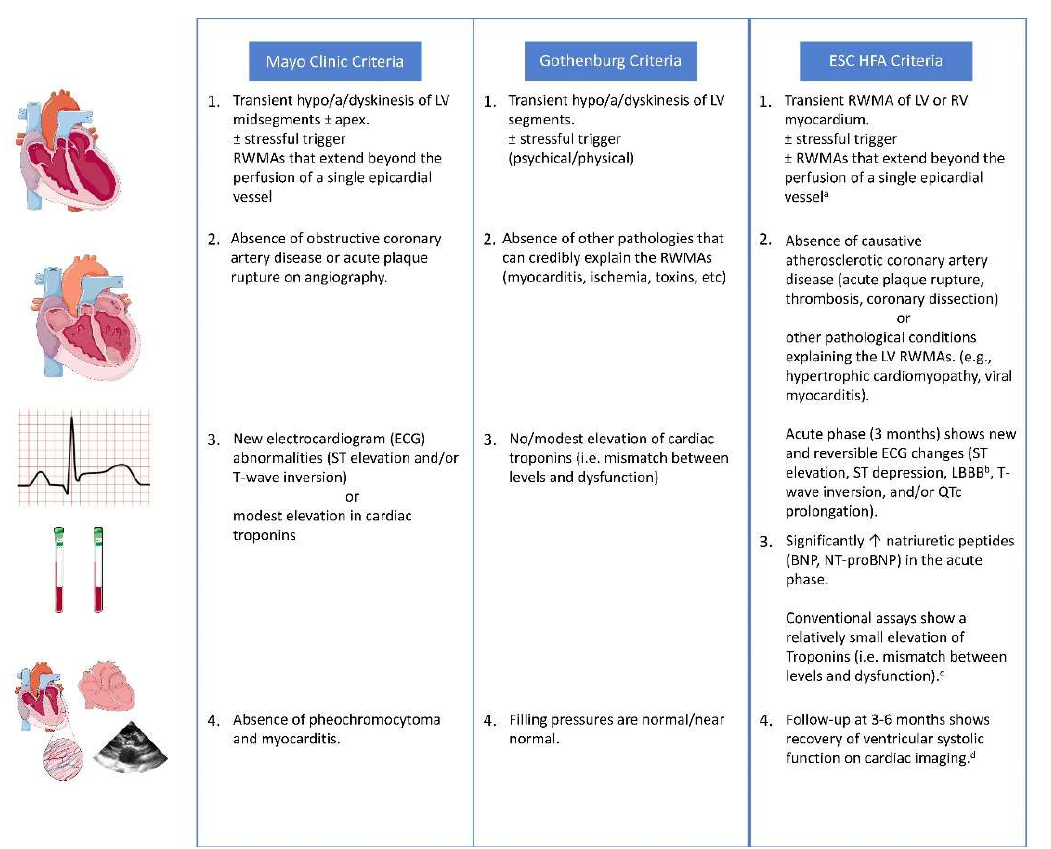
Table 1. Differential Diagnosis of Broken Heart Syndrome and their clinical presentation.